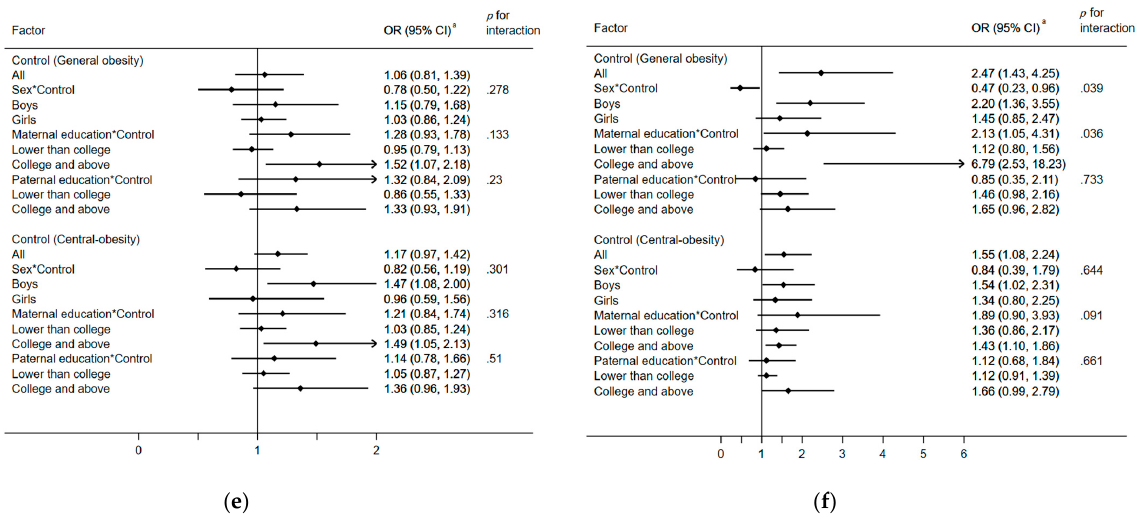
Figure 1. Longitudinal associations of parental feeding practices with general obesity and central obesity of children, stratified by child age, child sex, and maternal and paternal educations—the Childhood Obesity Study in China Mega-Cities ( n = 2139). ( a ) Concern—children ( ≤ 12 years); ( b ) Concern—children (>12 years); ( c ) Pressure to eat—children ( ≤ 12 years); ( d ) Pressure to eat—children (>12 years); ( e ) Control—children ( ≤ 12 years); ( f ) Control—children (>12 years). a : Child sex, child school level, child general obesity (or central obesity), child city of residence, maternal and paternal BMI, and maternal and paternal educations were adjusted as covariates in the mixed-effects model. In child age- and sex-stratified and maternal and paternal education-stratified analyses, models adjusted for the same variables except for child age and child sex, and maternal and paternal educations. Analysis of each parental feeding practice was conducted in 28 separate mixed-effects models for one specific outcome. *: Means the two variables were multiplied and added as an interac- tion term in the mixed-effects model. Variable definition: General obesity was defined using sex- and age-specific BMI cutoff points according to the Chinese National Standard, “WS/T 586-2018